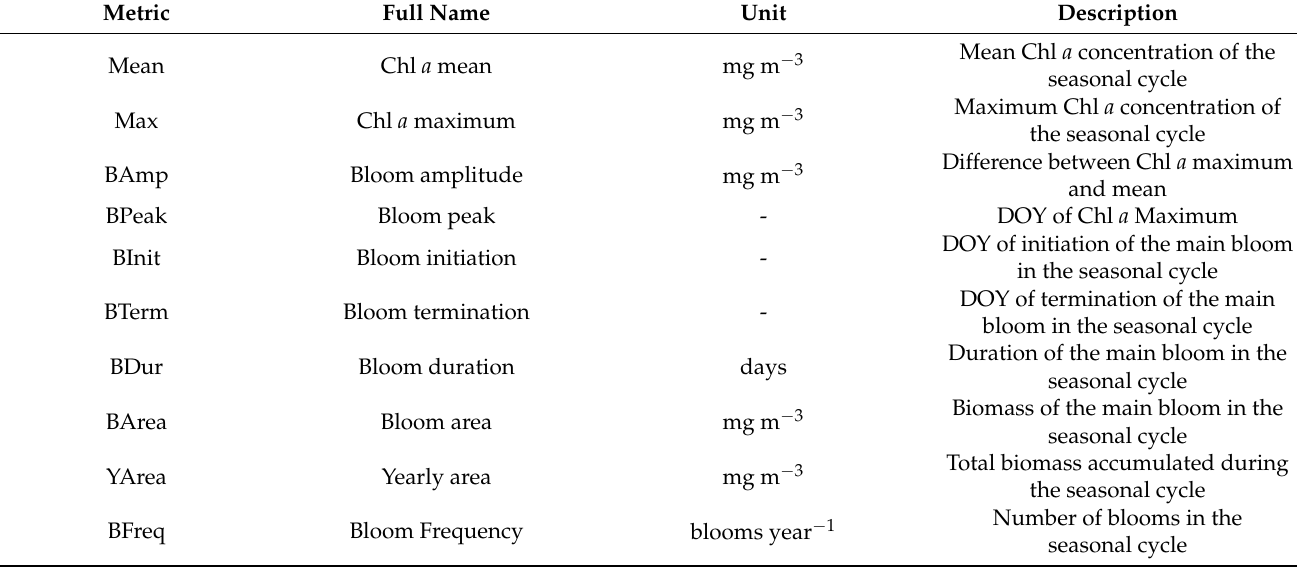
Table 1. Summary of the phenology metrics used in this work, including description. DOY stands for the day of the year.